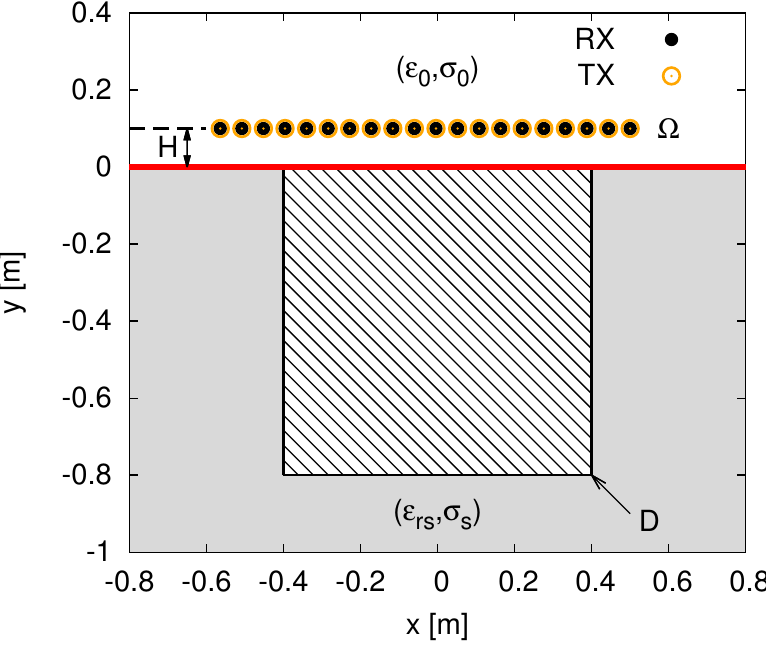
Figure 1. Geometry of the 2D-TM GPR-MI